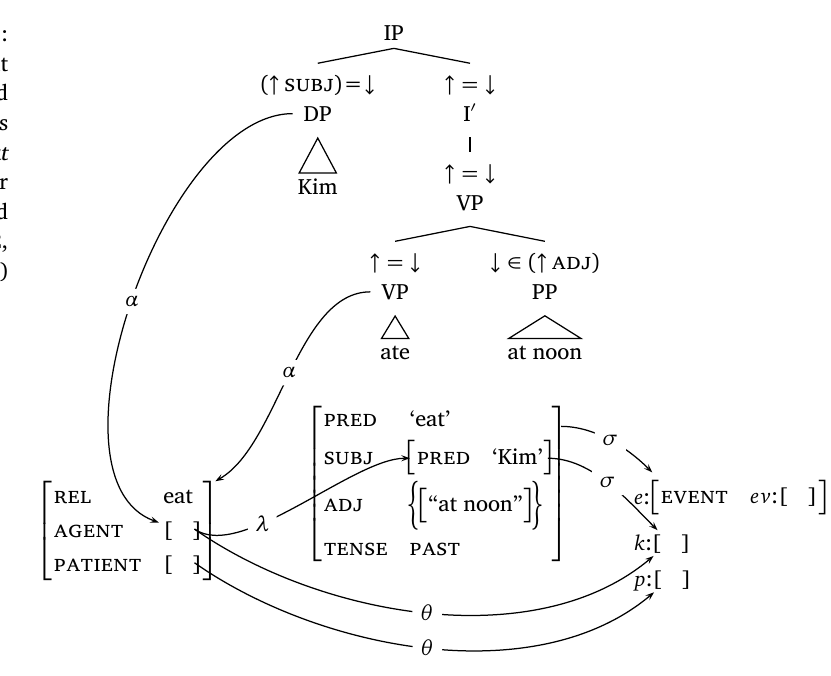
Figure 1: Relevant structures